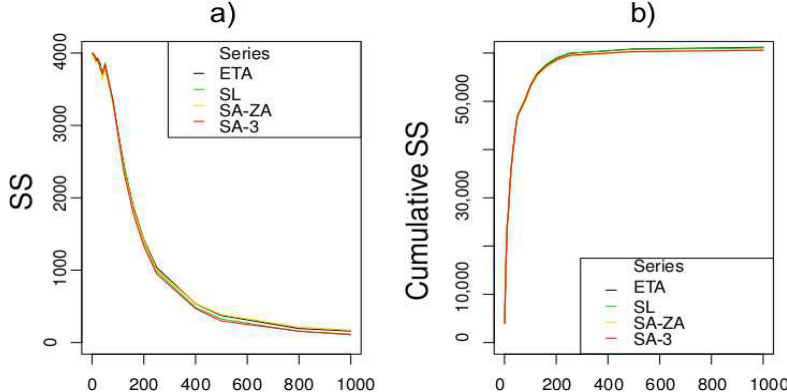
Figure 6. Number of segments for the PAA configuration; ( a ) SS vs. number of segments; ( b ) cumulative SS vs. number of